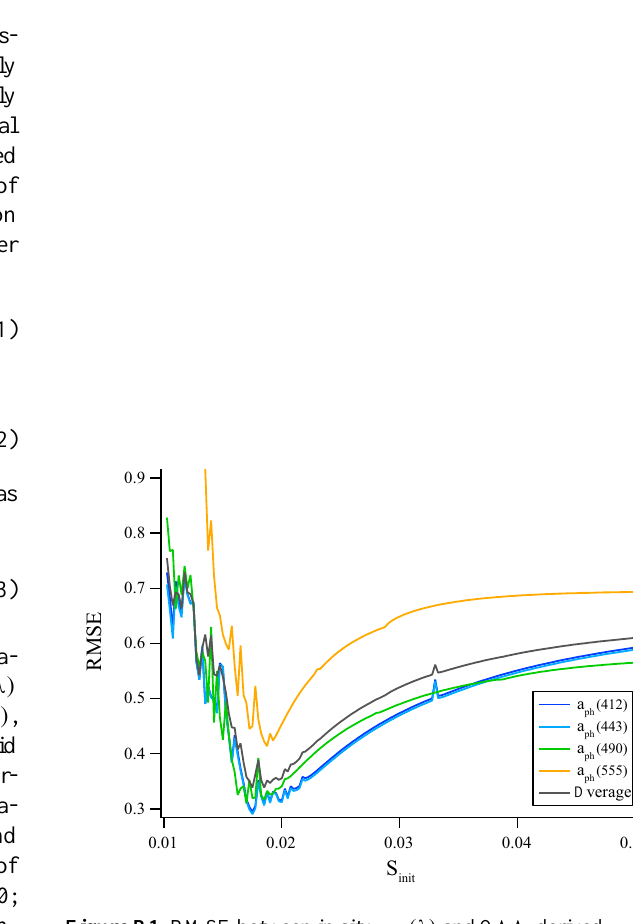
Figure B1. RMSE between in situ a ph (λ) and QAA-derived a ph (λ) as a function of the initial spectral slope of a dg ( S init ) . Lines coloured in blue, sky blue, green, yellow, and grey denote a ph (412), a ph (443), a ph (490), a ph (555), and the average of them, respectively. The optimum value of S init was determined when the RMSE for the average was at a minimum (i.e. 0.019). Note that the RMSEs were calculated for log-transformed a ph (λ)